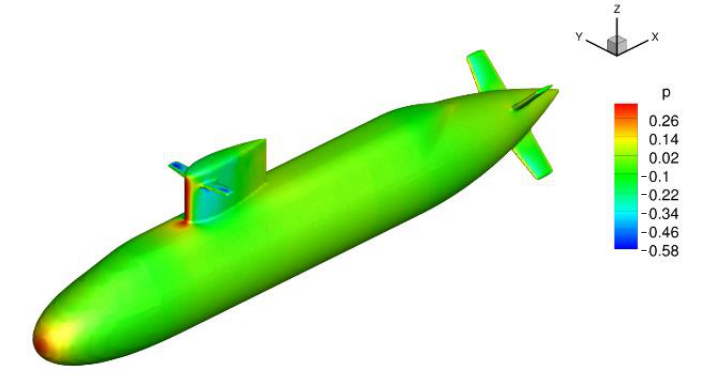
Figure 9. Non-dimensional pressure contours of the submarine surface.